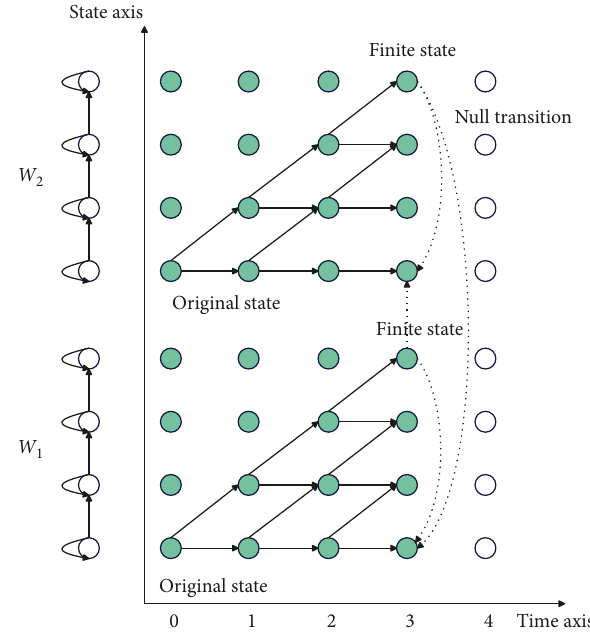
Figure 7: Continuous speech